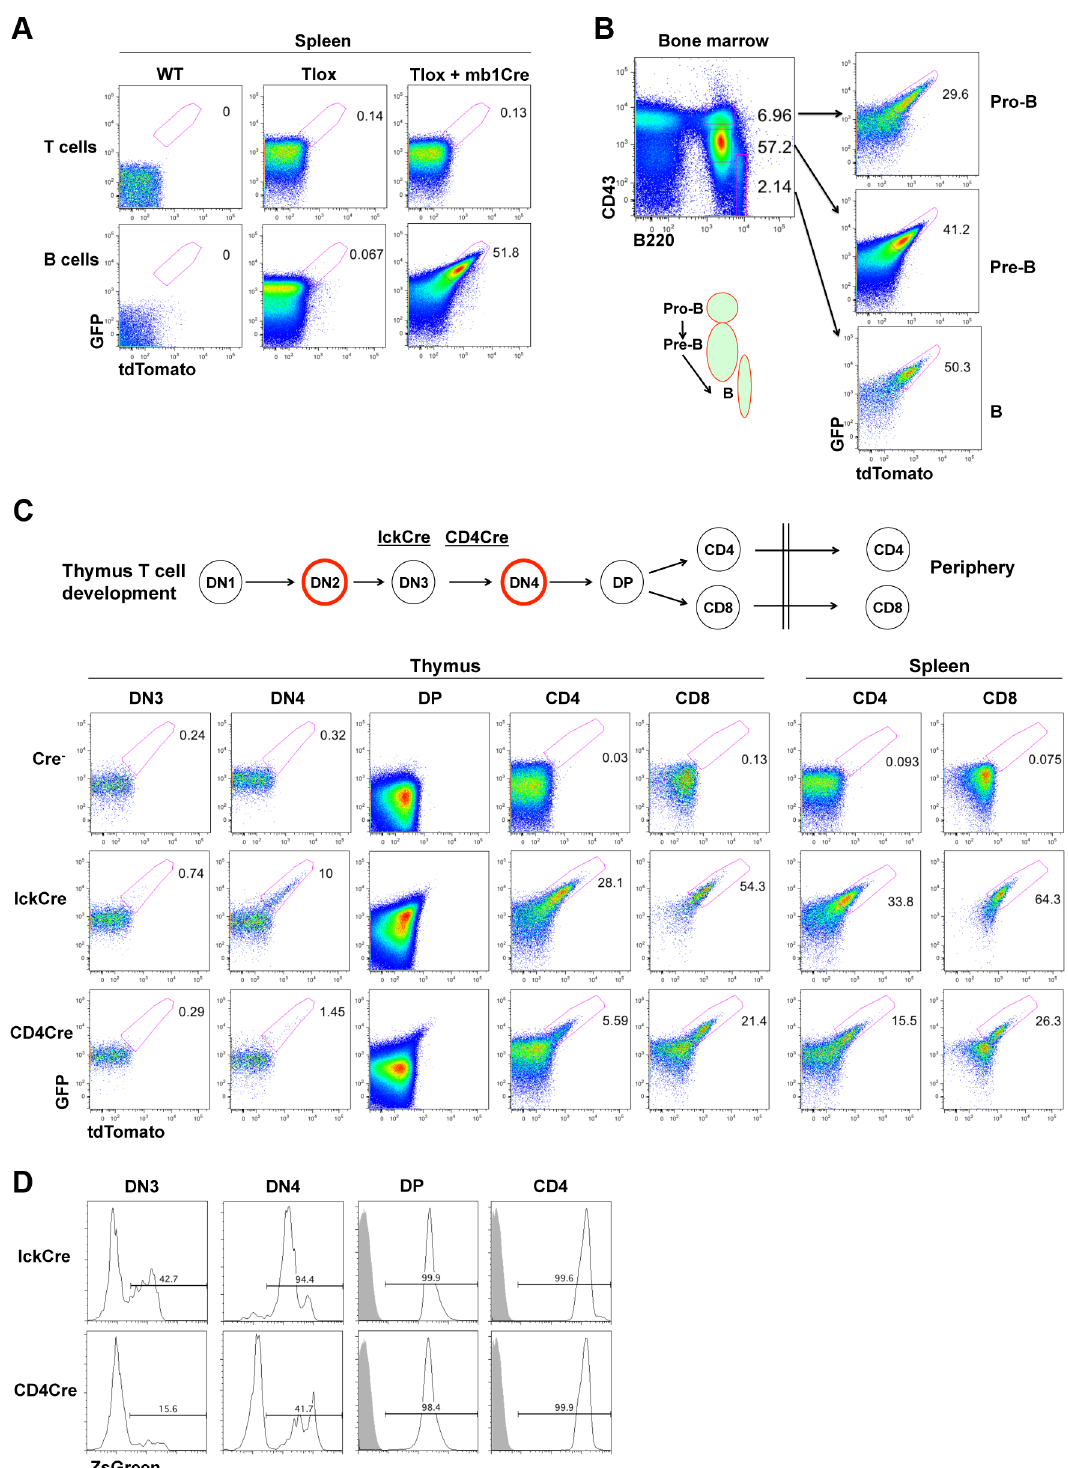
Figure 2. Tlox tracking lymphocyte proliferation invivo . (A) One-month old wild type, Tlox transgenic, Tlox and mb1Cre double transgenic mice were analyzed by gating on live T cells (TCR b + ) or B cells (B220 + ) from the spleen. tdTomato positive cells were highlighted by a region gate in the plots. (B) Bone marrow from Tlox and mb1Cre double transgenic mice was analyzed with CD43 and B220 markers. Pro-B, Pre-B and mature B cells were defined as CD43 hi B220 low , CD43 med B220 low and CD43 low B220 hi , respectively, and are indicated in the FACS plot and the diagram below. Each fraction was analyzed for GFP and tdTomato expression with the tdTomato positive fraction marked in the plot. (C) Diagram and representative FACS plots of major stages of T cell development in the thymus and periphery. Red circle indicates cells undergoing proliferative expansion. The starting time for lckCre and CD4Cre expression around the DN3 stage are indicated by their relative position in the diagram. FACS analyses of tdTomato expression are displayed in sequential order according to stages of T cell development for the Tlox mice (upper panel), the Tlox and lckCre double